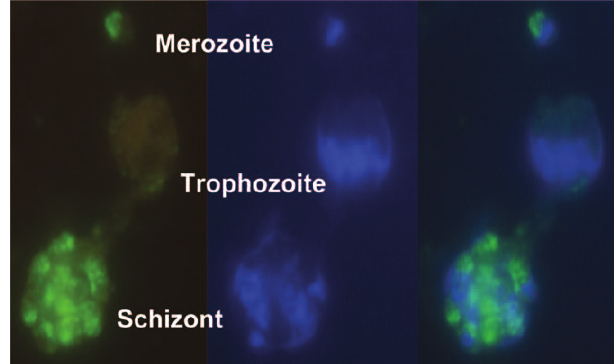
Figure 2. Inhibition of rPvDBPII Binding to Human Red Blood Cells by Antibodies Rabbit (A) and human (B) anti-PvDBPII Ab were tested to observe inhibition of the interaction of the rPvDBPII protein and Duffy-positive human erythrocytes. In erythrocyte-binding assays, the bars indicate the mean binding percentage of four separate experiments ( 6 standard deviation) relative to pre-bleed rabbit serum or nonspecific human IgG (150 l g/ml). In parallel experiments run with Duffy-negative cells, binding was always , 5% (unpublished data). Fy6 antibodies (50 l g/ml; recognize N-terminal region of the Duffy receptor) were used to show relative inhibition compared to the affinity-purified human anti-PvDBPII Ab.